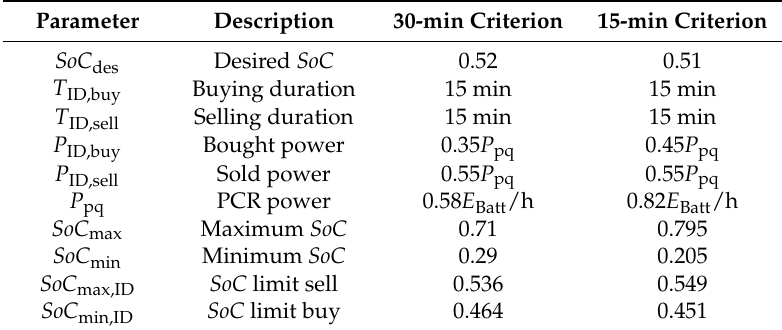
Table 7. Ideal parameter set evaluated via simulation of years 2013 and 2014.